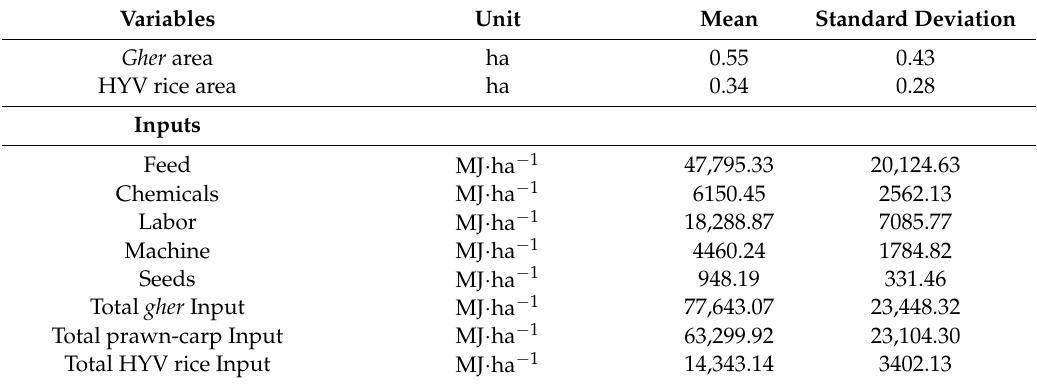
Table 2. Summary statistics of the input-output and socio-economic factors of the gher farming